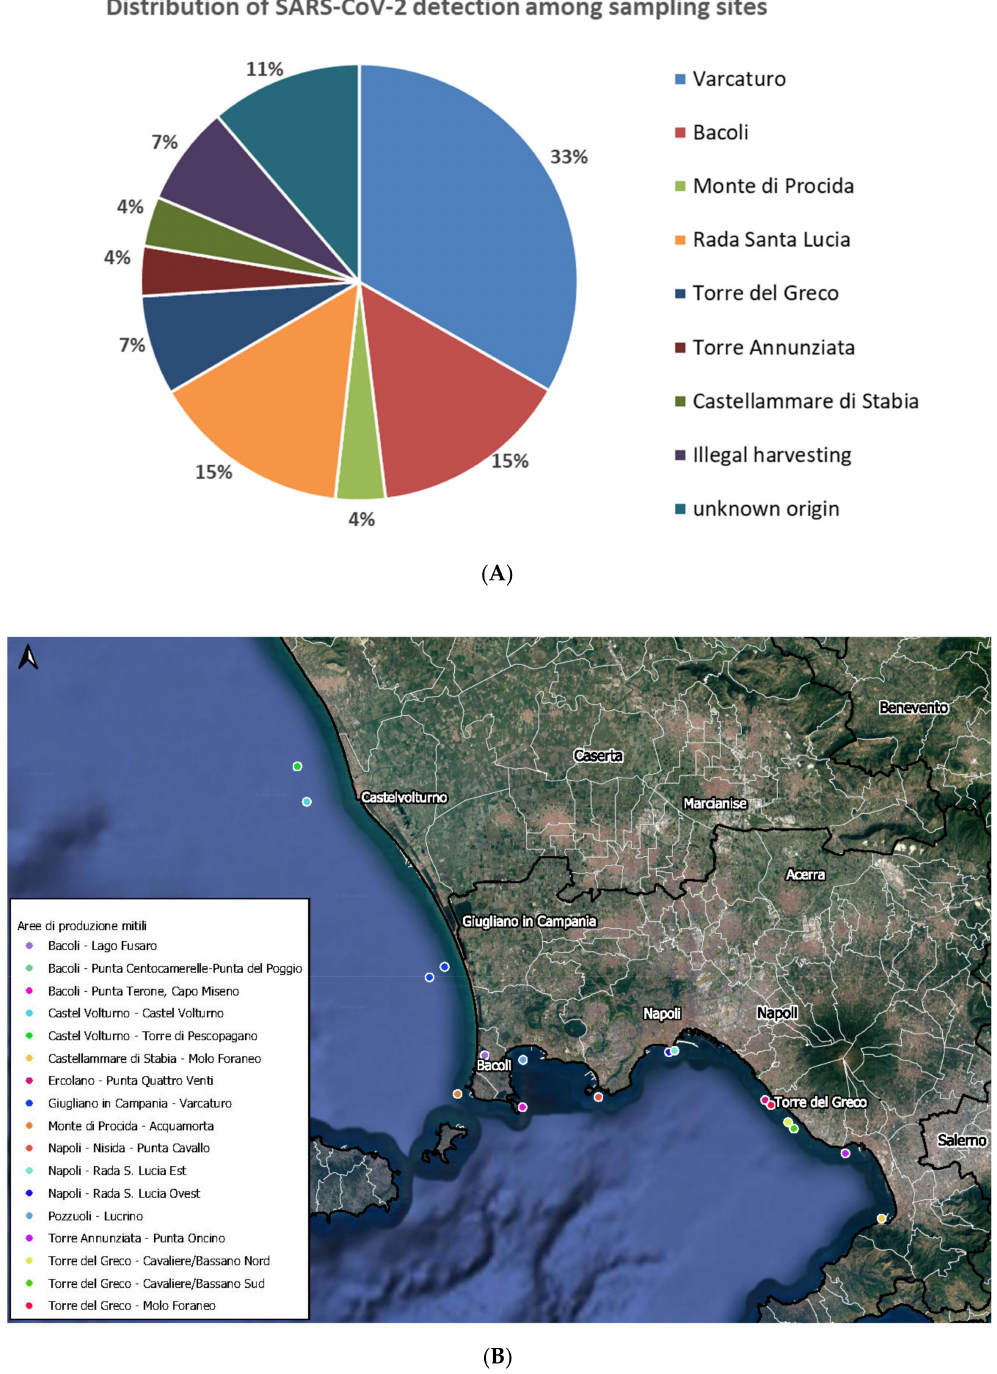
Figure 1. ( A ) Percentage of SARS-CoV-2 positive samples according to sampling sites. ( B ) Distribution of sampling sites in the Gulf of Naples (Campania region,